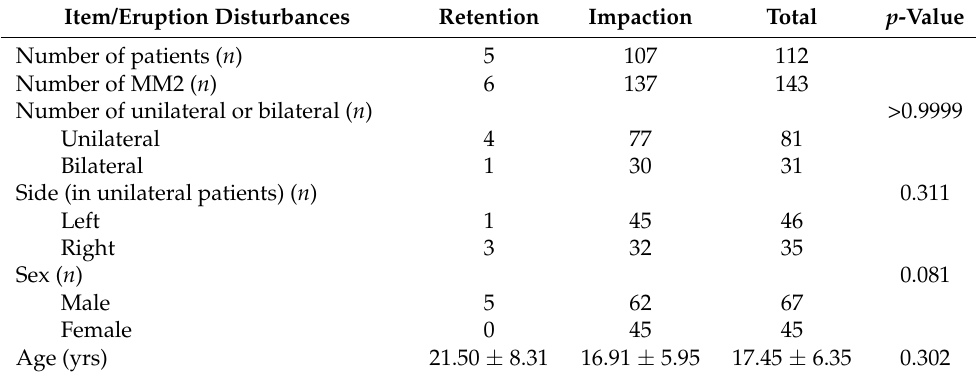
Table 1 . Patient demographics and baseline information based on impaction and retention.